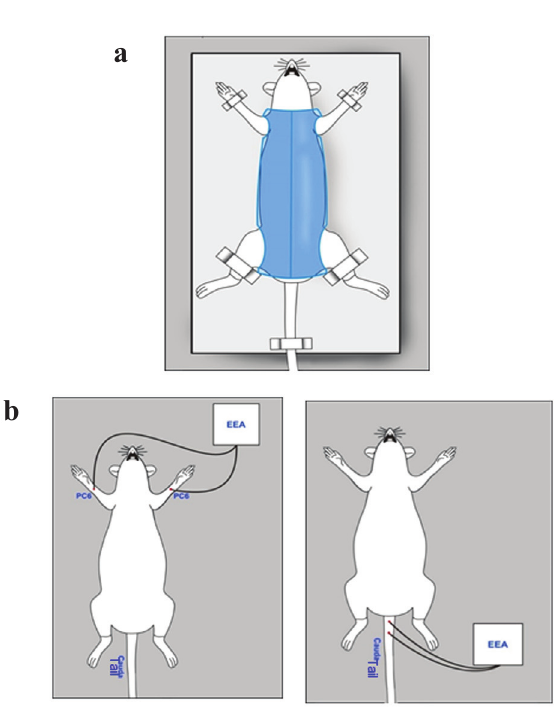
Figure 1 - (a) Schematic representation of immobilization and (b) of electroacunpucture in PC6 or (c) in the rat tail.